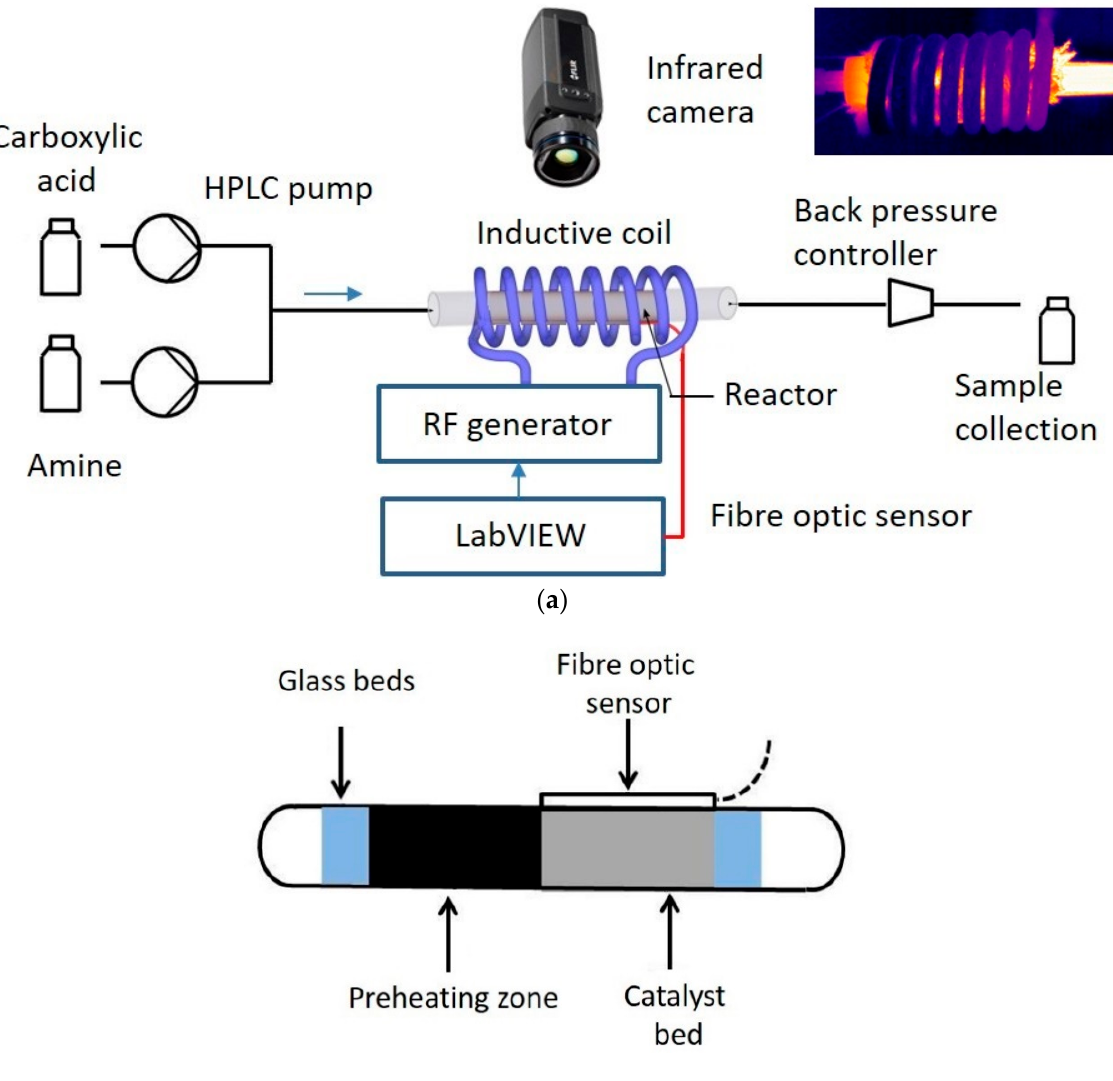
Figure 7. ( a ) A schematic view of the experimental set-up. A characteristic temperature field measured with the IR-camera shown in the top right corner. Blue color corresponds to 20 °C and white color: 130 °C. ( b ) A schematic view of the packed bed.